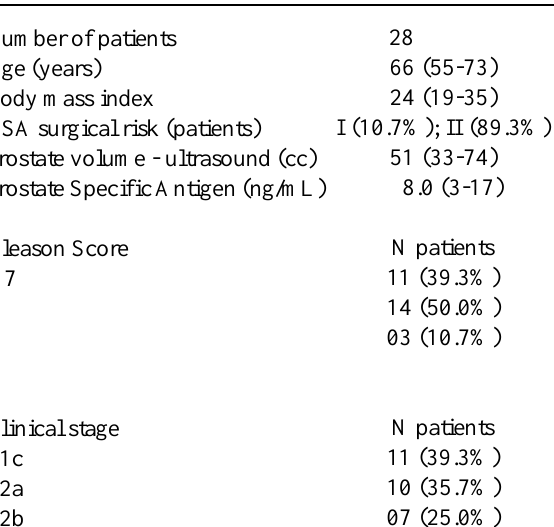
Table 1 – Demographic data and preoperative character- istics of patients undergoing extraperitoneal endoscopic radical prostatectomy with duplication of open